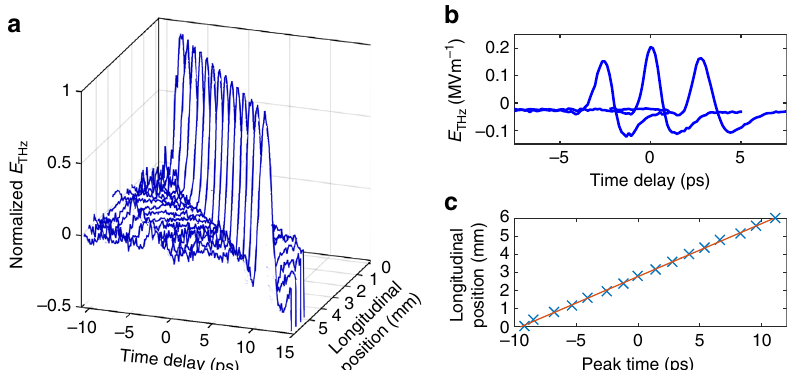
Fig. 6 Measured terahertz pulse propagation in a plane parallel to the LiNbO 3 emitting surface. a Electric fi eld temporal pro fi les as a function of position along the LiNbO 3 surface. The fi eld strength is normalised to the peak strength at each measurement position. b Example terahertz electric fi eld pro fi les taken from the same data set shown in a , without normalisation. c Arrival time of the peak electric fi eld as a function of longitudinal position. The red line is linear fi t to the peak positions and corresponds to a phase and group velocity of 0.98